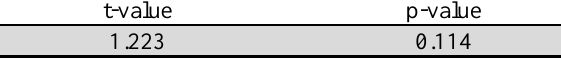
Third hypothesis at 95% confidence level t-value